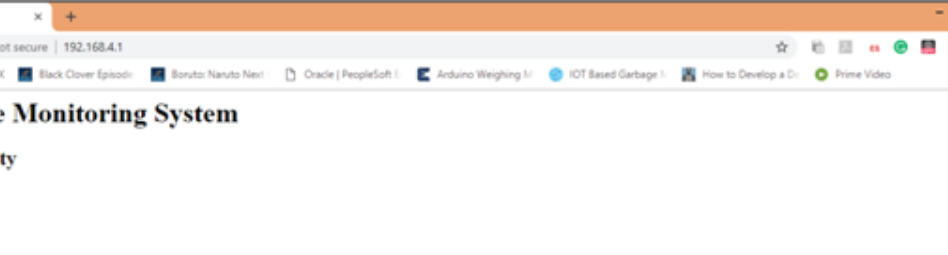
Figure 18. Monitoring system output (in this case, the bin is empty, the output is empty). A fuzzy inference system with GA is integrated for image classification. This classification distinguishes between recyclable and non-recyclable garbage waste. Figure 19 illustrates the different kinds of waste that have been appropriately marked and recognized by the classifier.